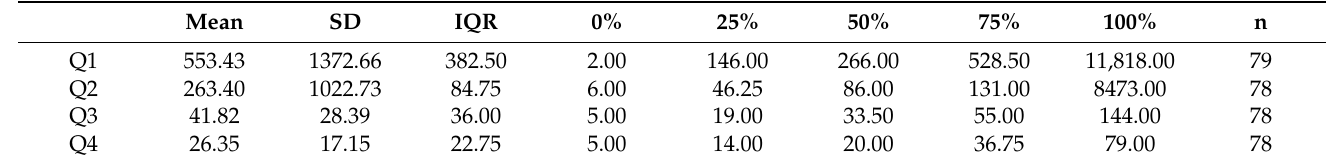
Figure 4 . ( a ) Axis OX population density. Axis OY rates of elderly women as victims of gender violence. ( b ) Zoom of previous one. Finally, it is important to point out that the Spatial autocorrelation of I Moran and the p -value show spatial distribution of the ROWVGV (I Moran 0.5404 p -value 0.0000) and between the ROWVGV with all the variables studied, being to a greater extent measured with the variables of the number of dependent persons and the percentage of women over 64 years of age and aging (see Figure 5, and Table 12).